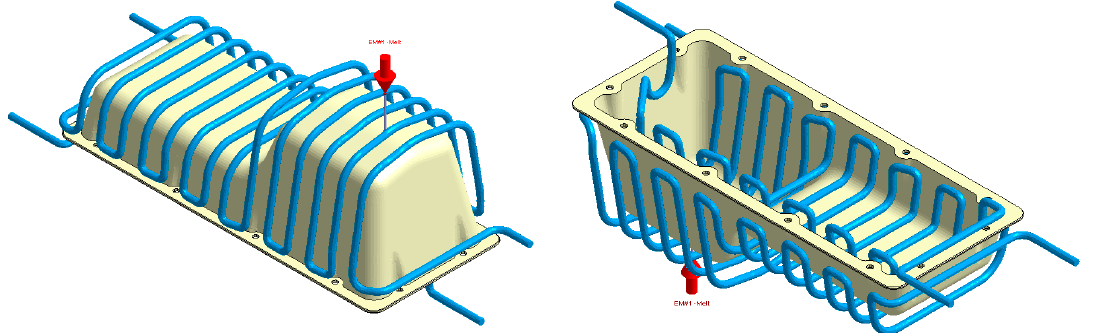
Figure 27. Cooling system design, Case C. Front view ( left ) and bottom view ( right ).